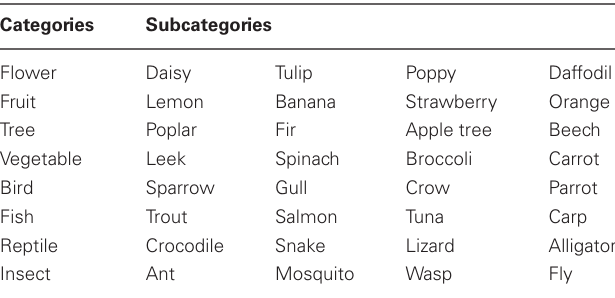
Table A1 | Categories and subcategories used in the linguistic task (English translation, actual items were in